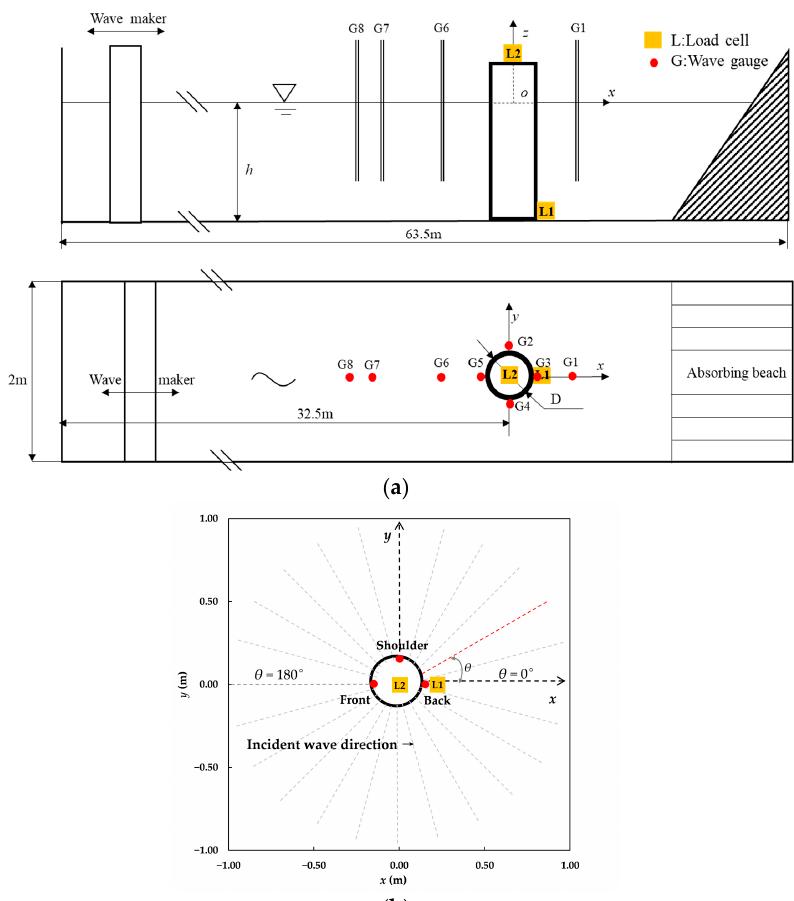
Figure 2. Sketch of the experimental setup: ( a ) global setting and ( b ) detail setting around the mono-pile.